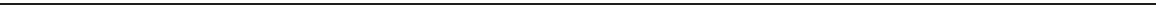
Fig. 1 De fi nition of the Src-regulated kinome. a MS-based kinome pro fi ling work fl ow. Lysates from differentially SILAC-labeled control and MCF-10A_Src cells were mixed and then subjected to kinome enrichment. Following in-gel or in-solution tryptic digestion, additional puri fi cation of phosphopeptides was undertaken using TiO 2 beads prior to MS analysis. b Distribution of Src-regulated kinases over the human kinome tree. Regulation at the expression and/or phosphorylation level is indicated by corresponding shading, as de fi ned in the legend. Eight main kinase groups are highlighted: AGC (containing protein kinases A, G, and C); CAMK (calcium/calmodulin-dependent protein kinase); CK1 (casein kinase 1); CMGC (containing cyclin-dependent kinase, MAPK, glycogen synthase kinase 3 and CDC2-like); STE (homologs of yeast sterile 7, sterile 11 and sterile 20); TK (tyrosine kinase); TKL (tyrosine kinase-like) and ‘ atypical ’ protein kinases (which includes ABC1, Alpha, Brd, PDHK, PIKK, RIO, and TIF1 kinases). c Contribution of individual kinase families to upregulated or downregulated kinase phosphosites. d Schematic representation of up- and downregulated FAK and EPHA2